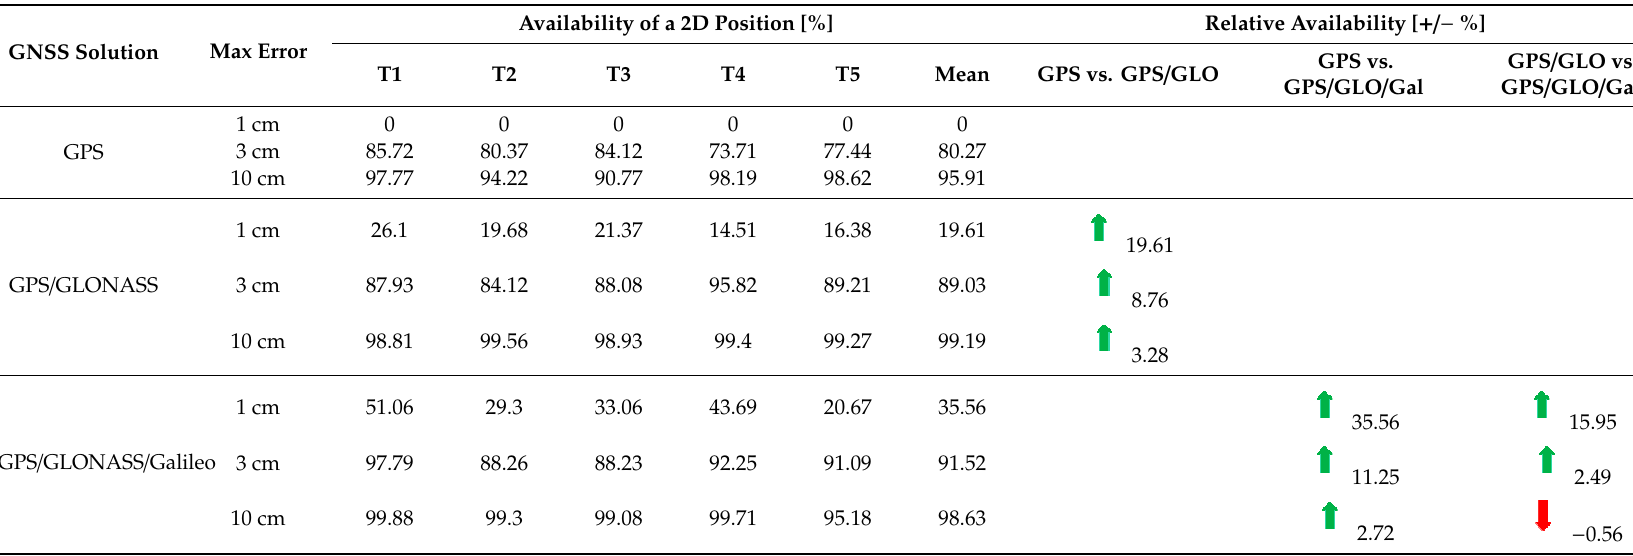
The results presented in Table 3 compare the selected parameters from two measurement series, taken, with RTK corrections, in the following variants: GPS and GPS/GLONASS. They show clearly that the use of the GNSS geodetic network, which sends corrections from two systems (GPS/GLONASS) rather than from one (GPS), improves greatly the satellite signal availability. The NoS increased by five, on average, which accounts for 76.82% of the constellation. As an obvious consequence of the situation, the mean PDOP coefficient decreased by 8.83%. Another comparison of the selected parameters (PDOP and mean NoS) was used for the measurements where the GPS/GLONASS and GPS/GLONASS/Galileo solutions were employed (Table 4). Table 4. The mean and minimum PDOP and the NoS used by the five GNSS geodetic receivers (T1– T5) in measurements during the journeys, with the use of RTK corrections, from GPS/GLONASS and GPS/GLONASS/Galileo satellites.